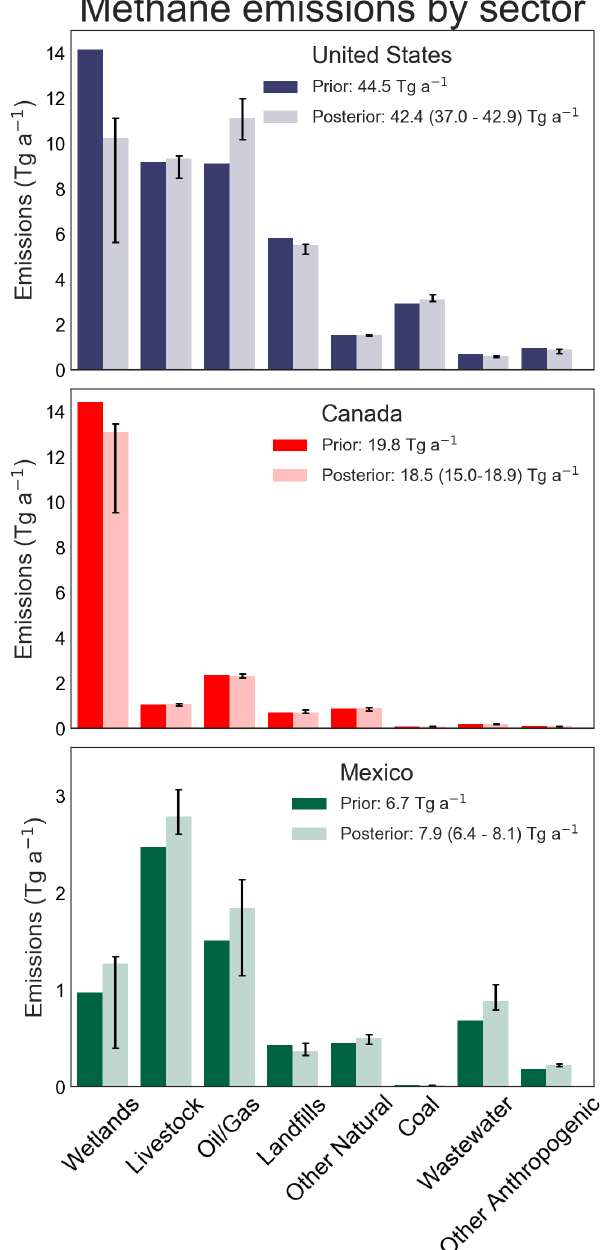
Figure 4. Mean 2010–2015 methane emissions per source sector for the contiguous US (CONUS), Canada, and Mexico. Values are shown for the prior estimates (Table 1) and for the posterior esti- mates after inversion of GOSAT data. Vertical bars show the ranges of results from the inversion